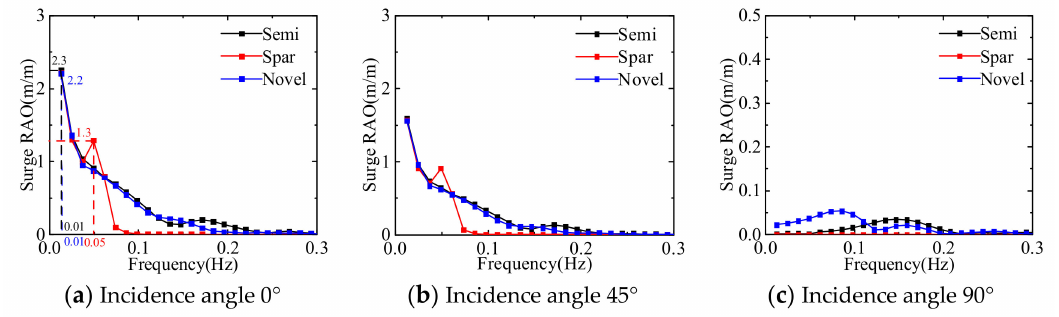
Figure 20. Comparison of the response amplitude operator in surge direction of three floating platforms.